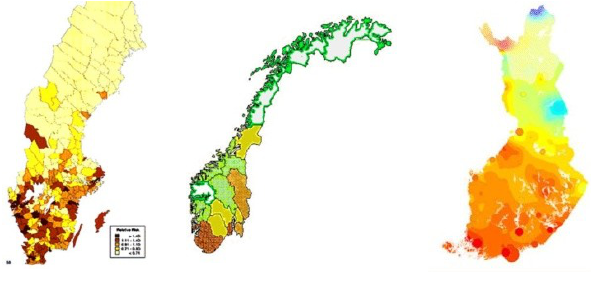
maps represent Sweden, Norway and Finland from left to right.